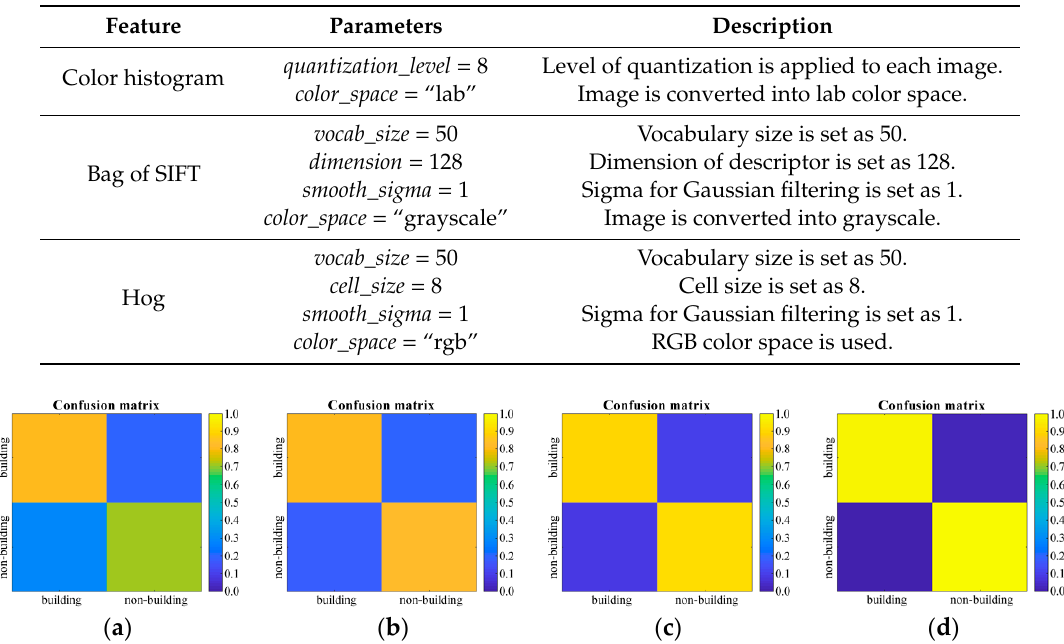
Figure 17. Comparison of confusion matrices of building and non-building classification in Random Forest and MSCNs. ( a ), ( b ), and ( c ) are the confusion matrices of the Random Forest classifier that uses color histogram, bag of SIFT, and Hog, respectively. ( d ) is the confusion matrix of the proposed MSCNs.